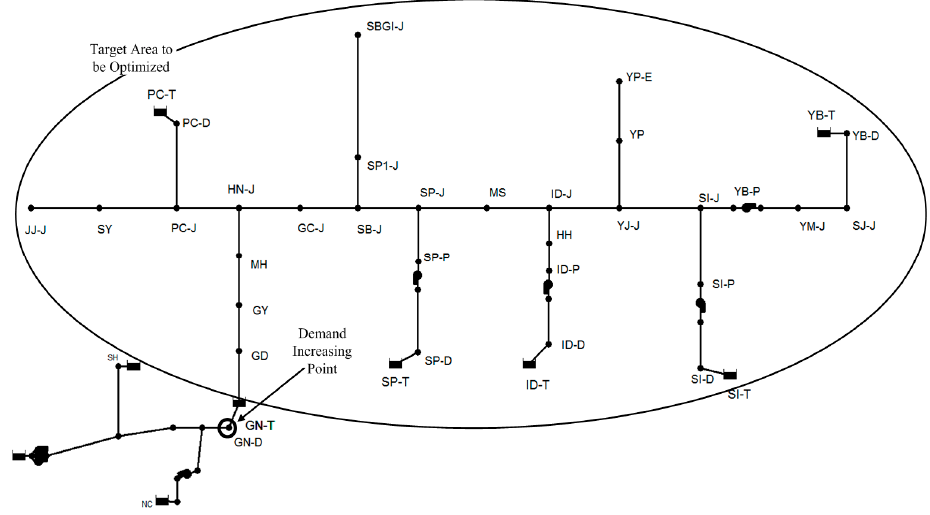
Figure 2. Target WSN (P city, Republic of Korea) (Yoo et al. [6]).